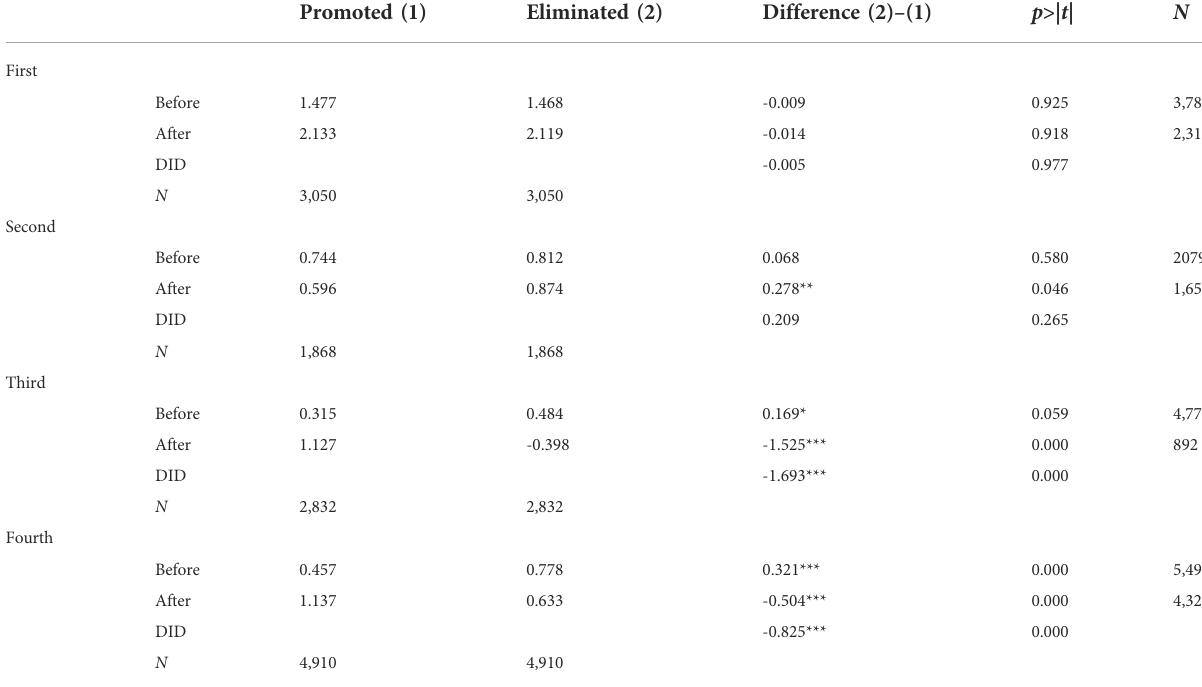
TABLE 2 DID regression results for sentiment tendency for four elimination matches.